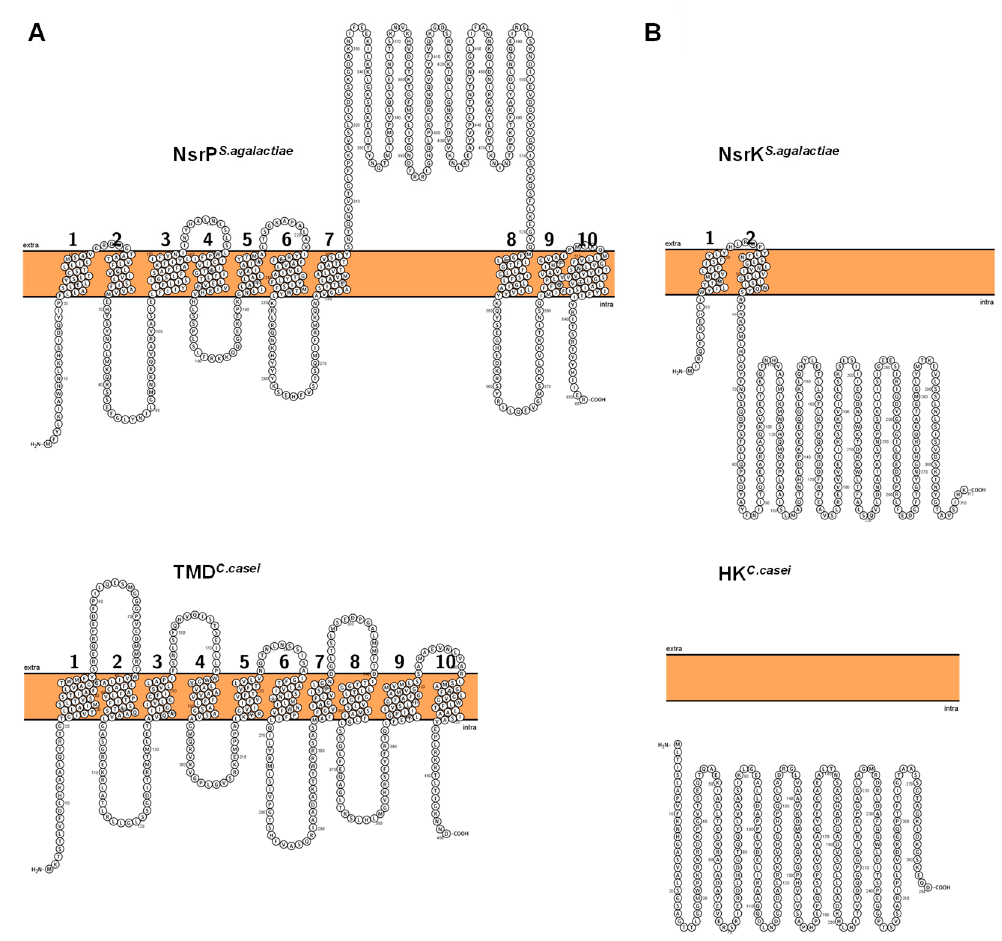
Figure 3. Transmembrane topology of ( A ) NsrP of S. agalactiae (upper left; Uniprot ID: A0A0E1EH51) and the predicted TMD in C. casei (lower left; Uniprot ID: W5XR13) and ( B ) HK NsrK of S. agalactiae (upper right; Uniprot ID: Q8DZW8) and the predicted HK in C. casei (lower right; UniProt ID: W5XQB7). Prediction and visualization was performed using Protter.